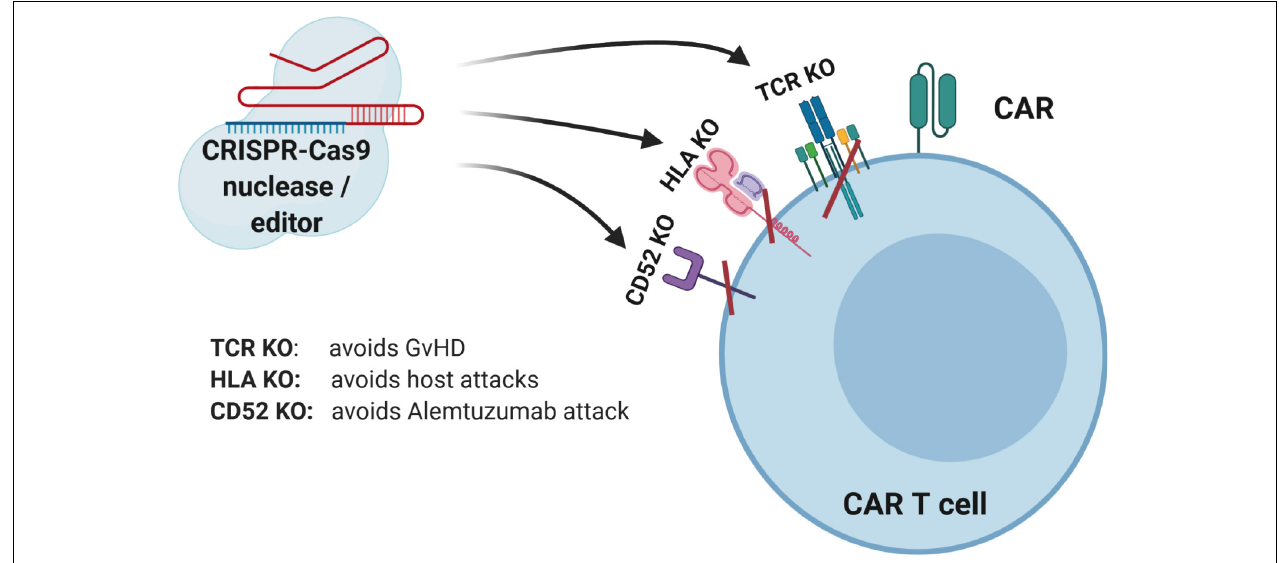
FIGURE 2 | CRISPR-Cas9-mediated gene editing of CAR T cells. The TCR can be knocked out to lessen the likelihood of graft versus host disease (GVHD). The HLAs can be knocked out to increase persistence of gene-modified cells. Knockout of receptors that can be targeted by other medications, such as antibodies, can be accomplished to allow selective survival of gene-modified cells, e.g.,